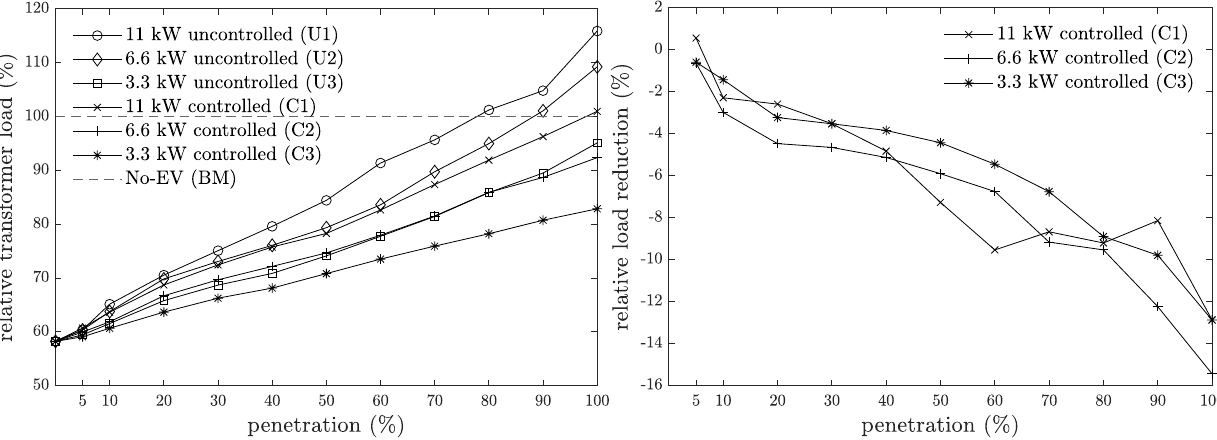
Figure 5. Maximum relative peak power at the transformer for the six scenarios ( left ), relative reduction in the peak power at the transformer by the voltage droop controlling ( right